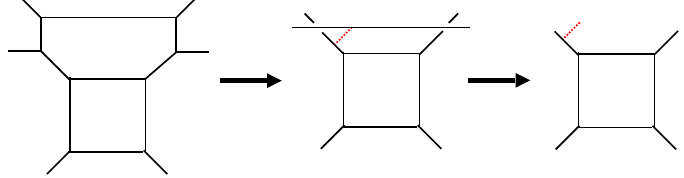
Figure 19 . The process of geometric transition. We can remove the framing after setting some of Kähler